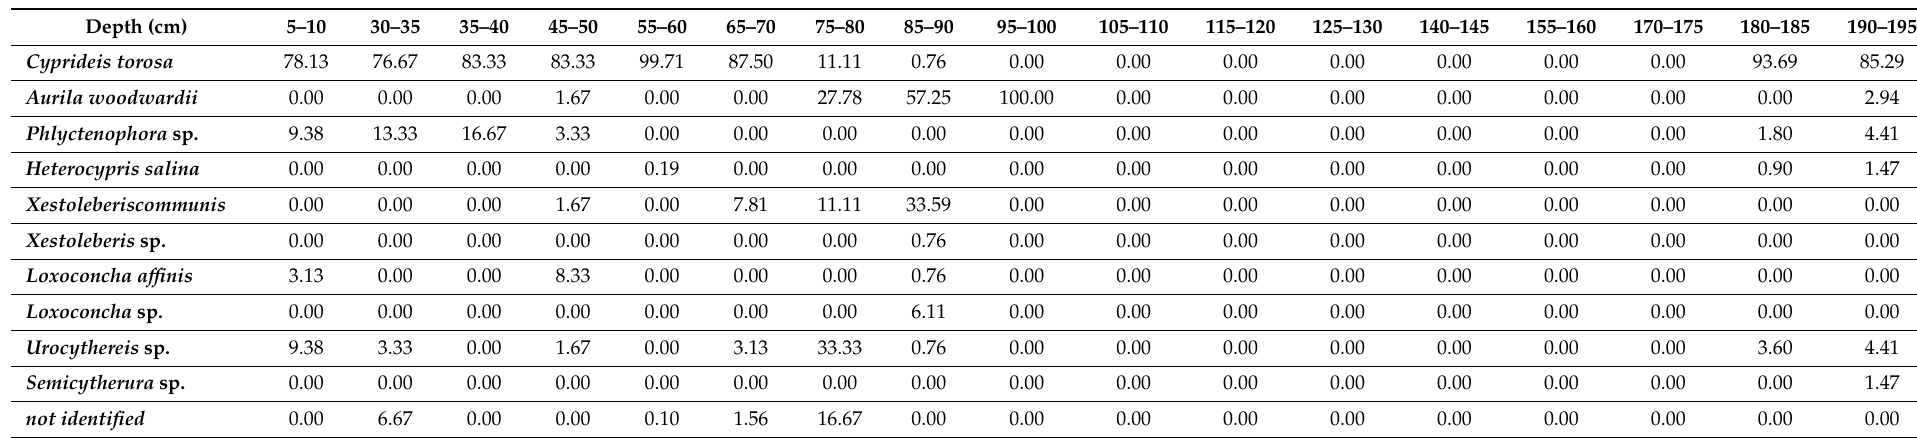
Table A6. Relative frequencies of the ostracod species in the studied samples of AKC2.